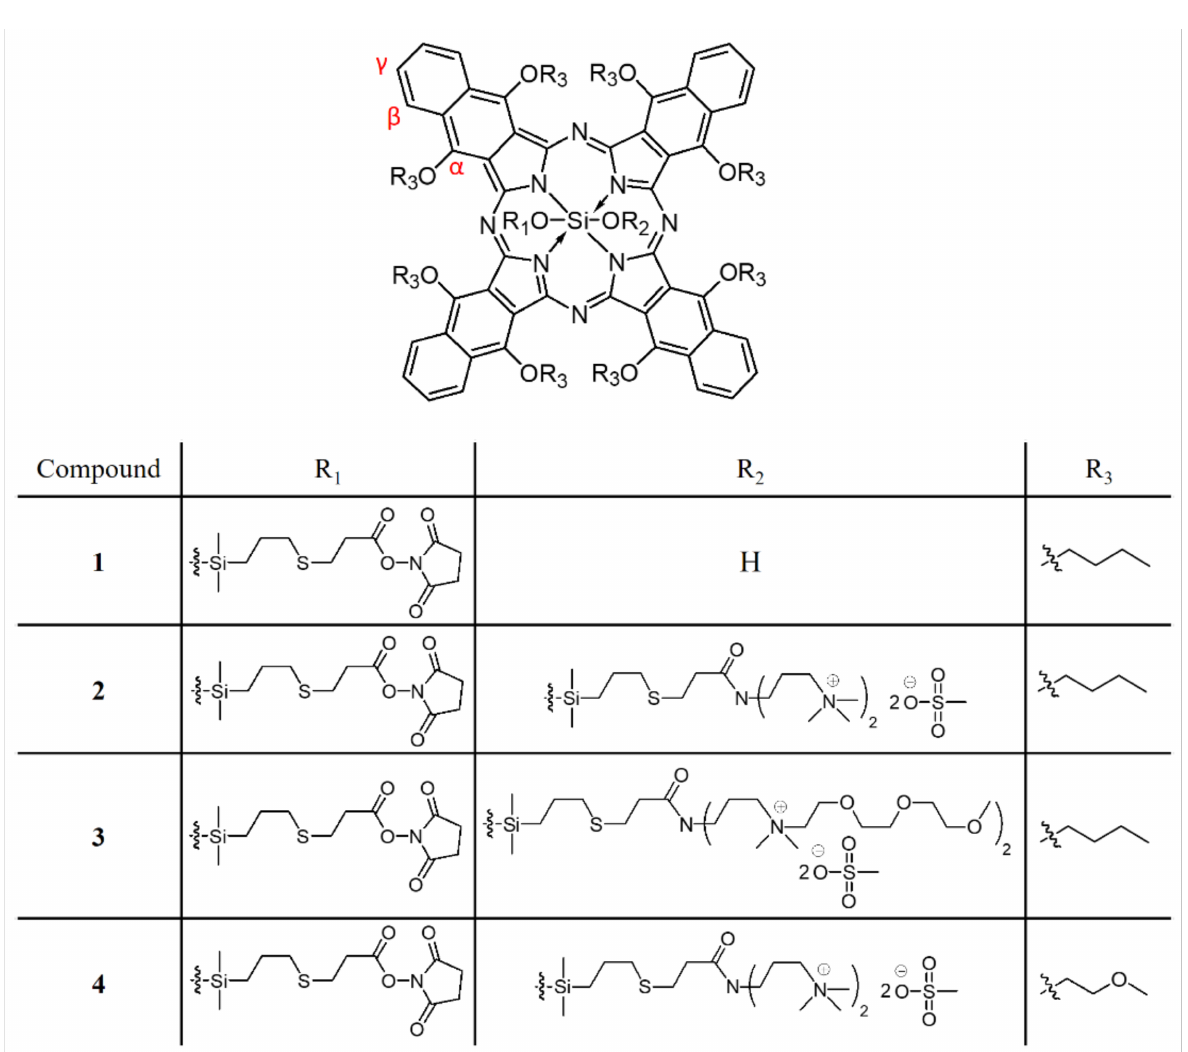
Figure 1. Chemical characteristics of silicon naphthalocyanine dyes 1–4 (SiNC(1–4)). SiNC(1–4) were prepared according to Scheme 1. The preparation of silicon naphthalo- cyanine dihydroxides substituted with butoxy groups (5) or methoxyethoxy groups (6) is discussed in the Materials and Methods section. Thiol groups were incorporated on one or both of the central silicon bonding sites via siloxy linkages, yielding 7 from 5, 8 from 5, and 9 from 6. 7 and 8 were obtained from a single reaction by adjusting the ratio of starting materials. NHS esters were incorporated via a Michael addition of the thiols to NHS acrylate, yielding 1 from 7, 10 from 8, and 11 from 9. Finally, SiNC(2–4) dyes were prepared by exchanging one of the NHS groups on 10 or 11 with bis(dimethylpropylamino)amine followed by amine quaternization with methyl mesylate, yielding 2 from 10 and 4 from 11, or triethylene glycol monomethyl ether methanesulfonate (preparation discussed in the Materials and Methods section), yielding 3 from 10. The physicochemical characteristics of the four dyes are summarized in Table